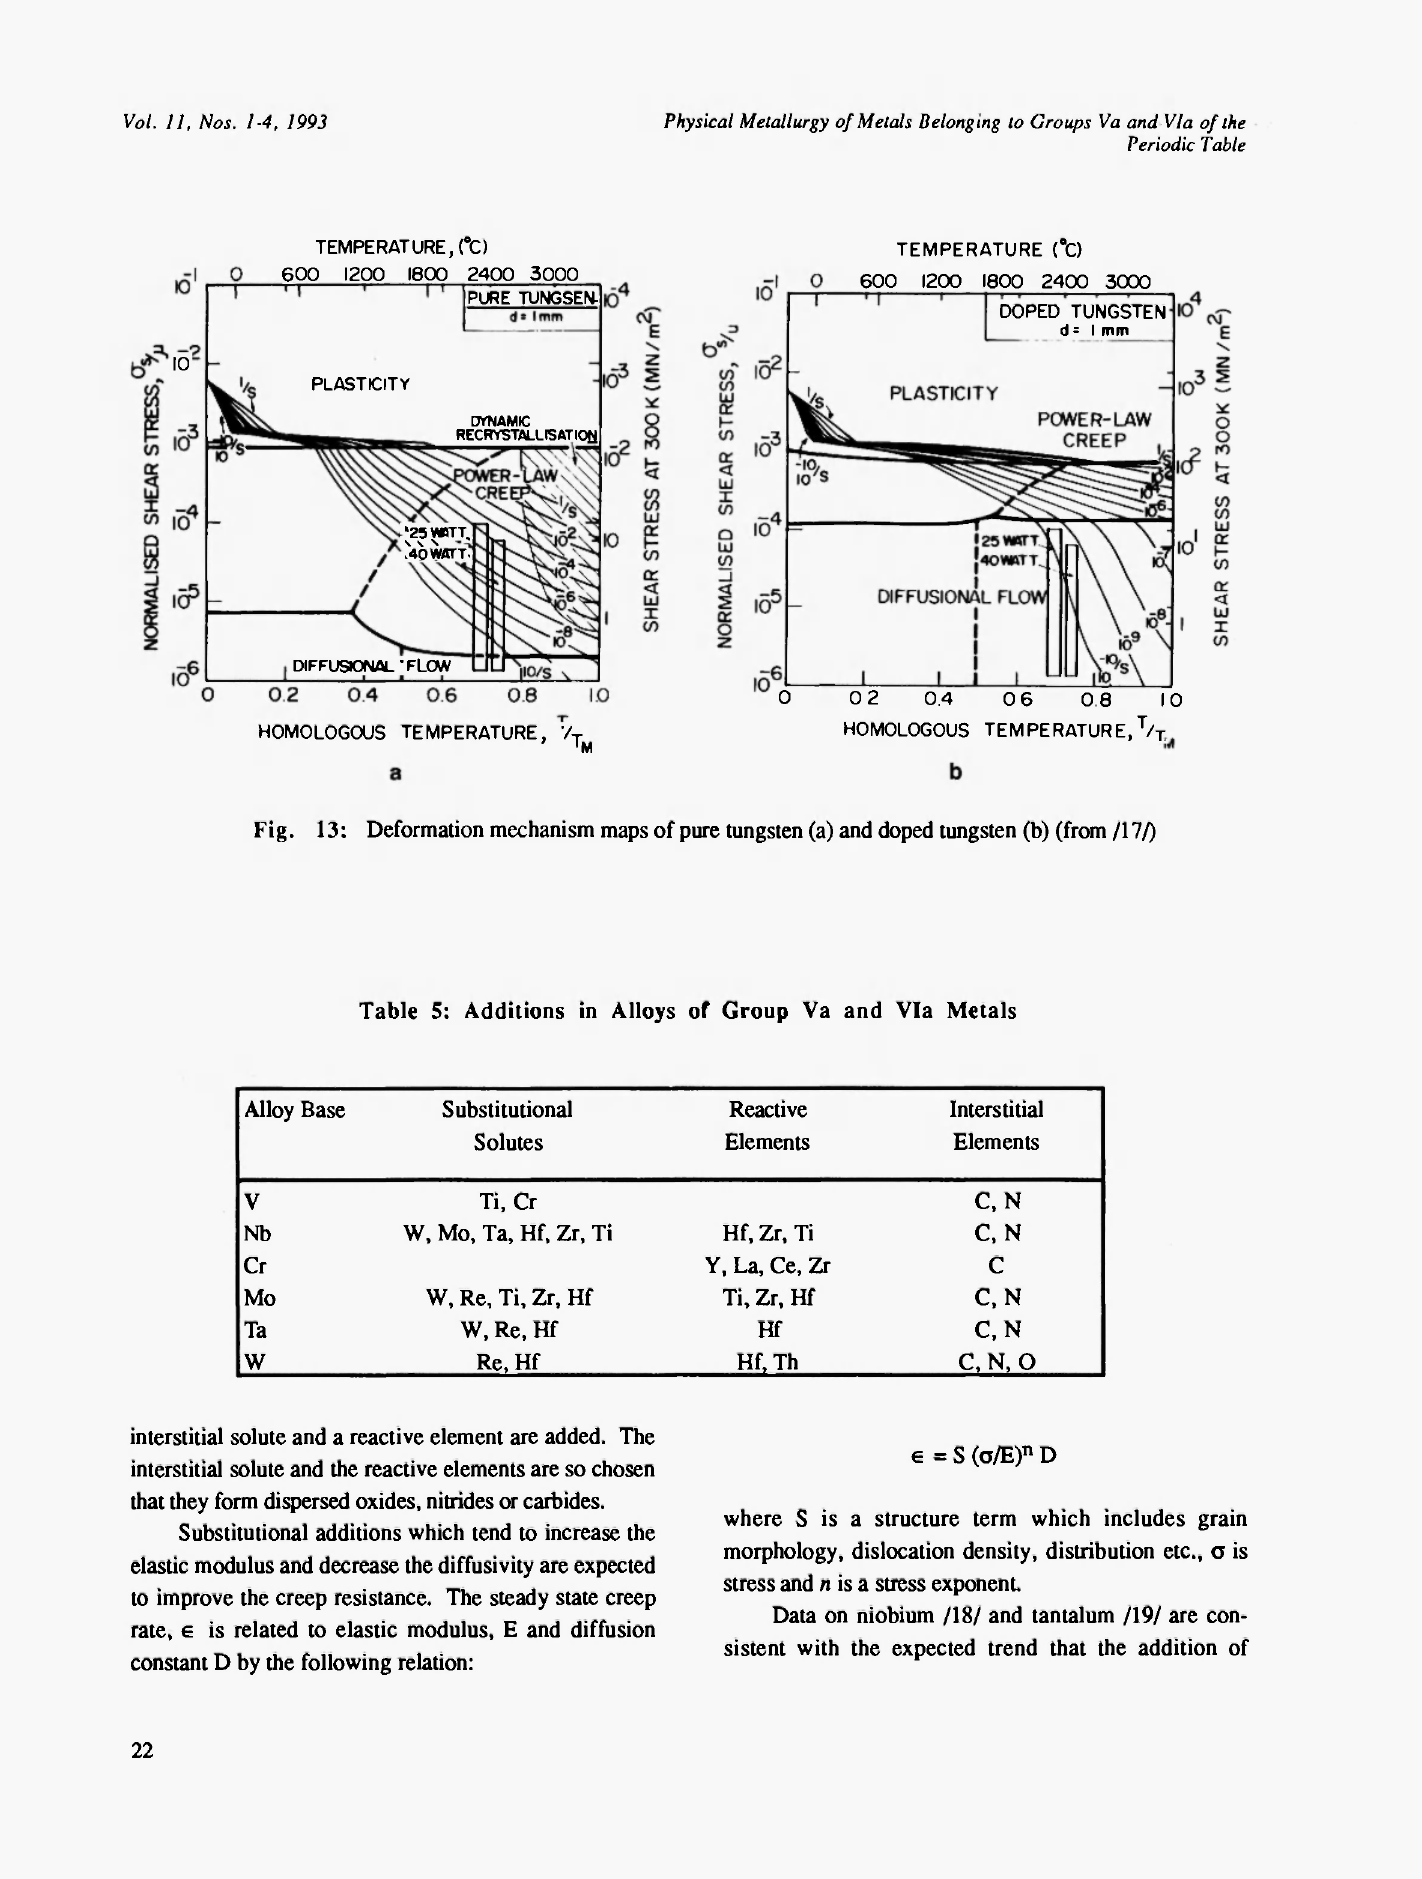
13: Deformation mechanism maps of pure tungsten (a) and doped tungsten (b) (from /17/)